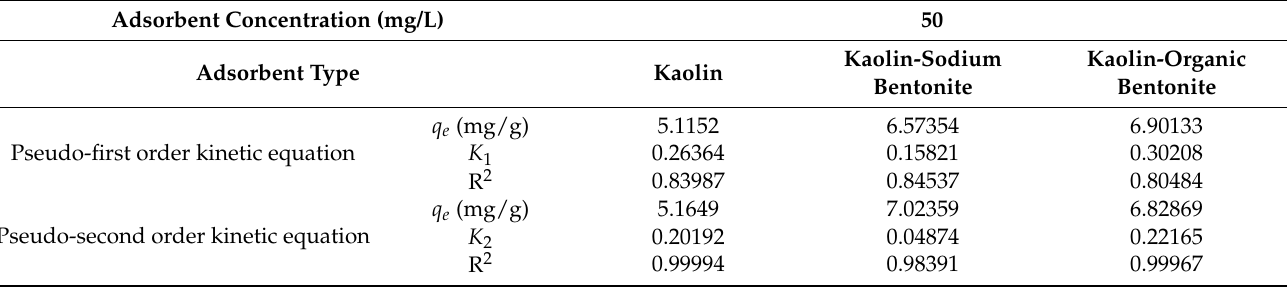
Figure 10. Adsorption kinetics of rhodamine B by different adsorbents: ( a ) pseudo-first order kinetic model; ( b ) pseudo-second order kinetic model. Table 3. Kinetic fitting of rhodamine B adsorption by different